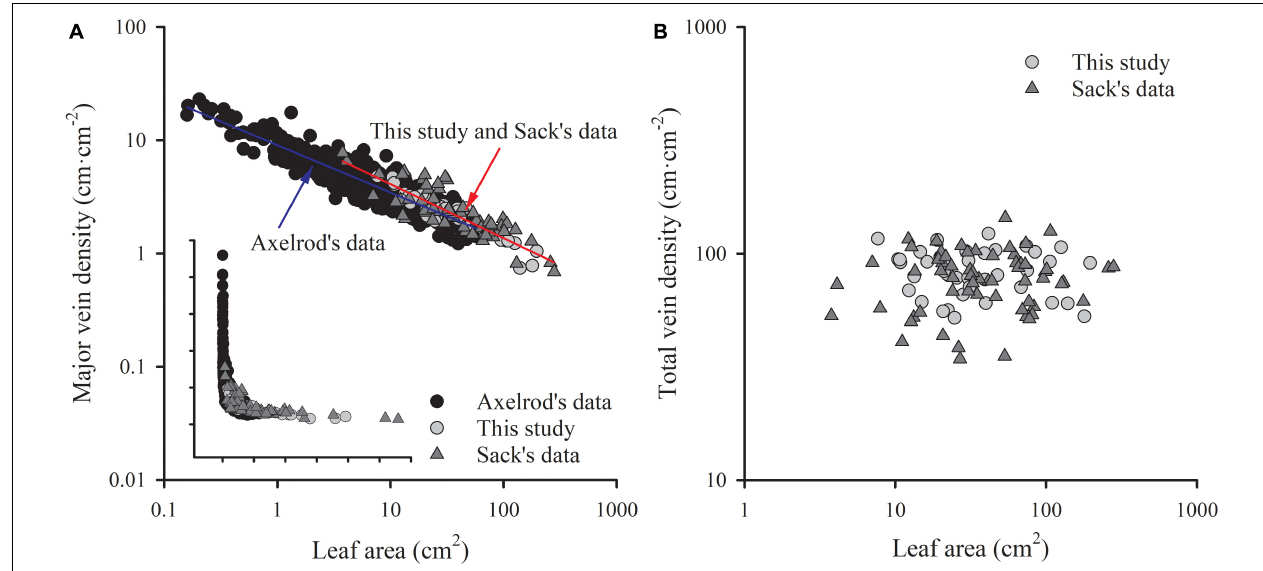
FIGURE 5 | The comparisons of the scaling relationship of major vein density with leaf area (A) , and the independence of total vein density from leaf area (B) in our study (39 woody species within subtropical forestry community), Sack’s data (63 comprehensive species), and Axelrod’s data. The red line is the common slope of this study and Sack’s data, while the blue line is the slope of Axelrod’s data. Inset in panel (A) is the same plot but with raw data.